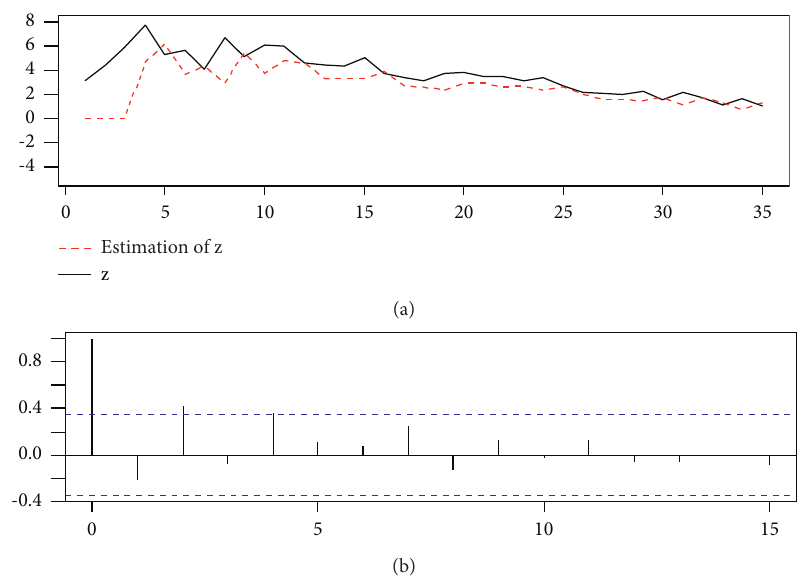
Figure 6: (a) Exact and estimated values of data based on Model (II). (b) ACF of residuals, h